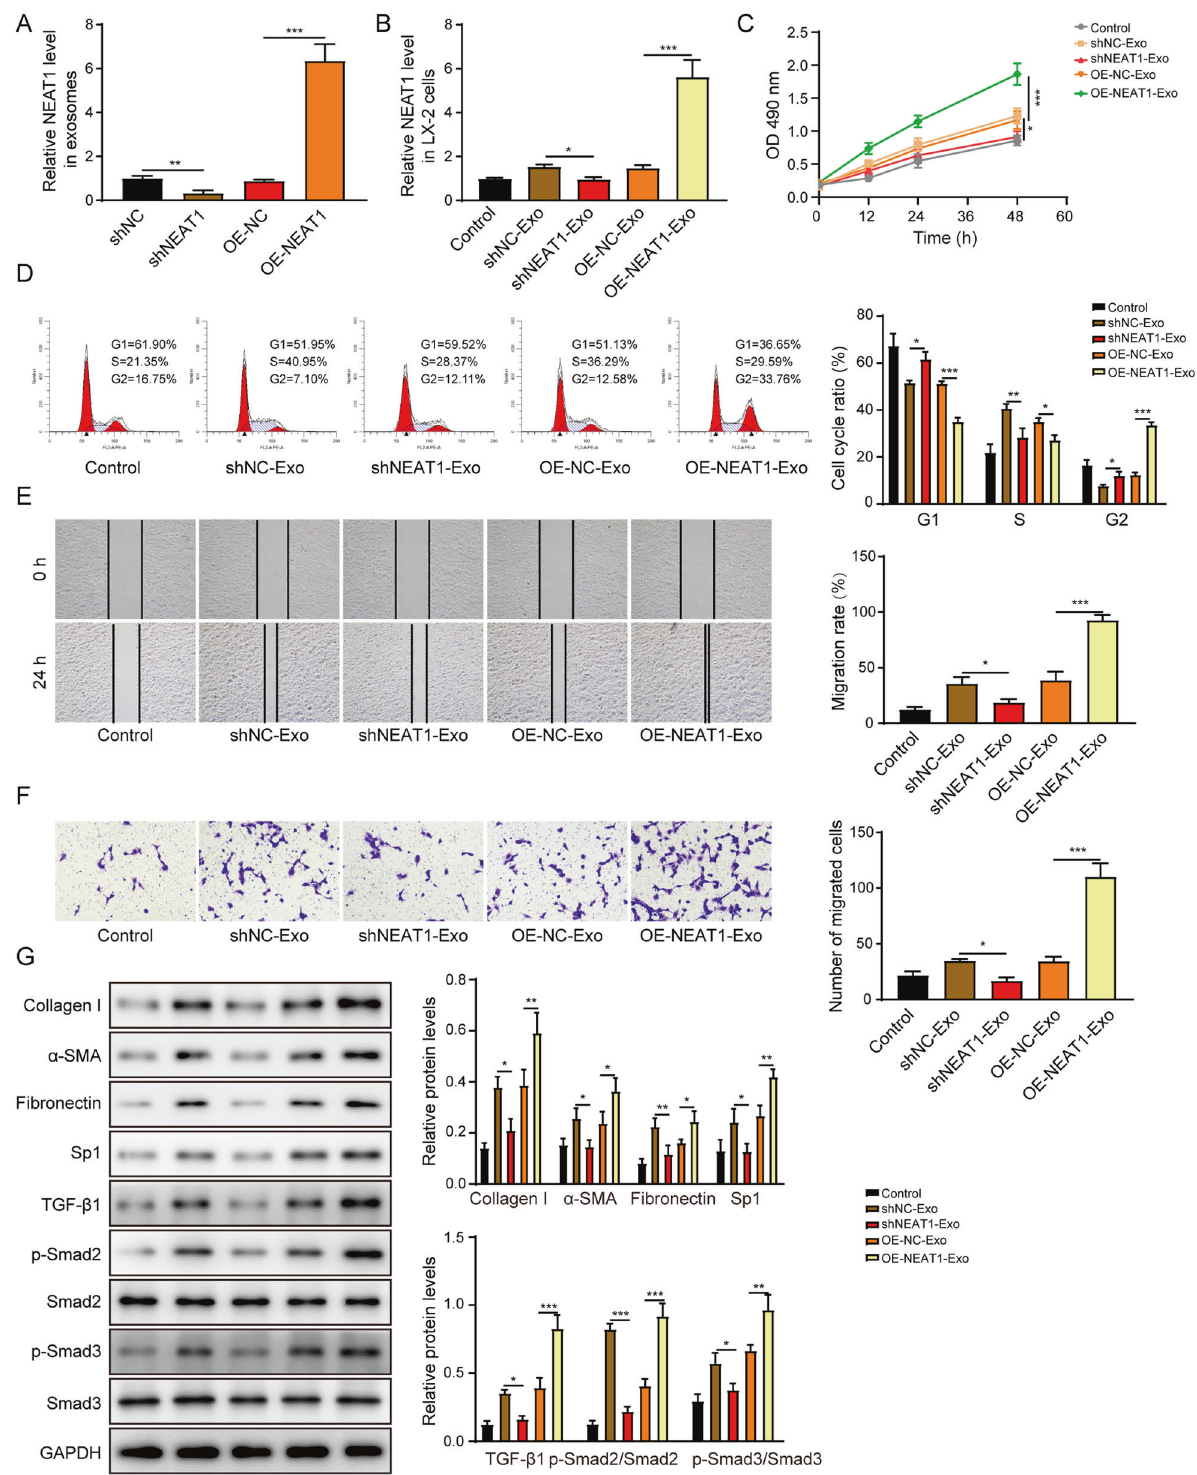
Fig. 3 Exosomal NEAT1 from THP-1 macrophages promotes the activation of HSCs. A The NEAT1 expression level was determined by qRT- PCR in exosomes from THP-1 macrophages. B The NEAT1 expression level was determined by qRT-PCR in LX-2 cells. C The proliferation of the LX-2 was examined by the CCK-8 assay. D The cell cycle of the LX-2 was examined by the fl ow cytometry. E , F The migration of LX-2 was determined by the scratch assay ( E ) and the transwell assay ( F ). G The protein levels of collagen I, α -SMA, fi bronectin, Sp1, TGF- β 1, p-Smad2, Smad2, p-Smad3, and Smad3 were measured by western blot. * p < 0.05; ** p < 0.01; *** p < 0.001.